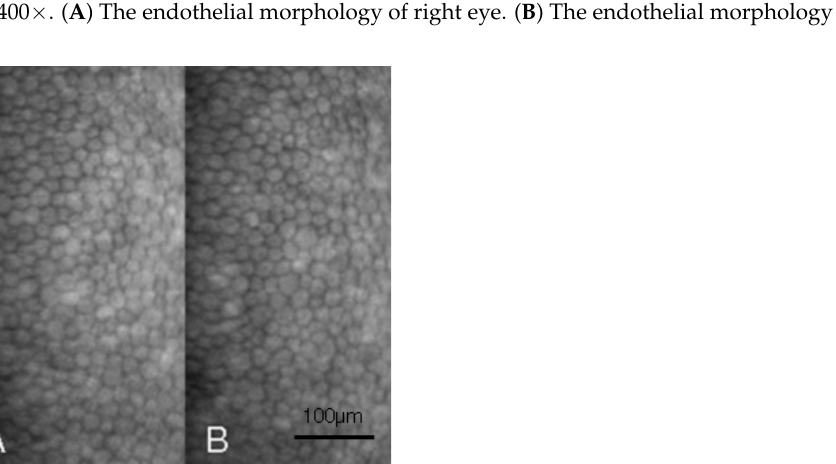
Figure 2. The endothelial cell morphology after topical ascorbic acid instillation immediately before surgery with nominal magnification of 400×. ( A ) The endothelial morphology of right eye. ( B ) The endothelial morphology of left eye.